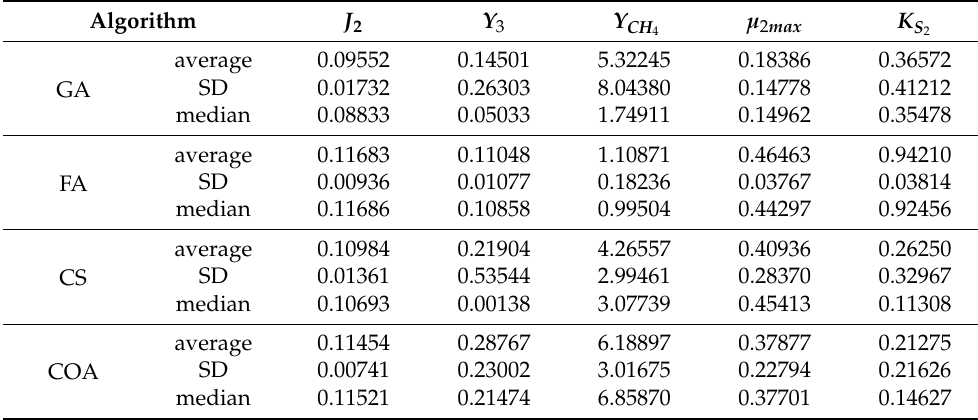
Table 3. Statistical analysis of the